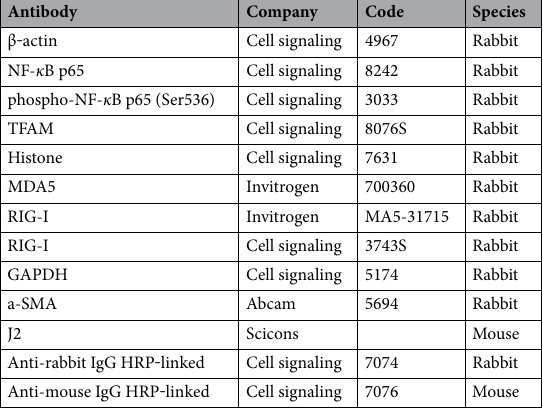
Table 2. Antibodies used for immunofluorescence staining and western